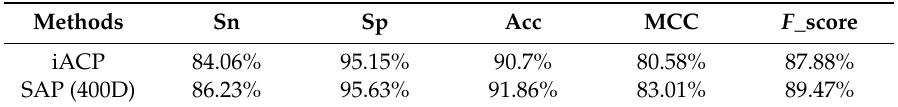
Table 1. Performance comparison with state-of-the-art methods.